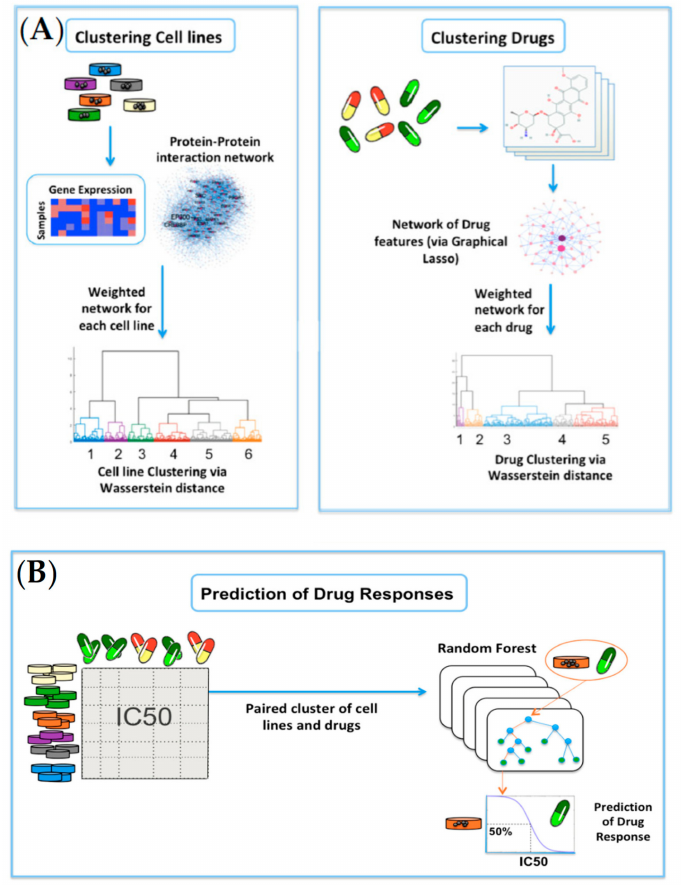
Figure 4. Overview of the network-based clustering and modeling of drug responses: ( A ) For clustering of cell lines, the gene-expression profiles for 915 cell lines were analyzed on the HPRD network. Invariant measures for individual nodes were then computed, and the Wasserstein distance (EMD) was computed between each pair of cell lines on the network. Lastly, hierarchical clustering was performed on the resultant Wasserstein distance matrix. For clustering of drugs, we obtained the cheminformatic features of 200 drugs, and built a data-driven network of cheminformatic features using the graphical LASSO. Similar to cell lines, hierarchical clustering was performed on the resultant Wasserstein distance matrix; ( B ) A random forest model was built on each paired cluster of cell lines and drugs to predict drug responses in log(IC50)